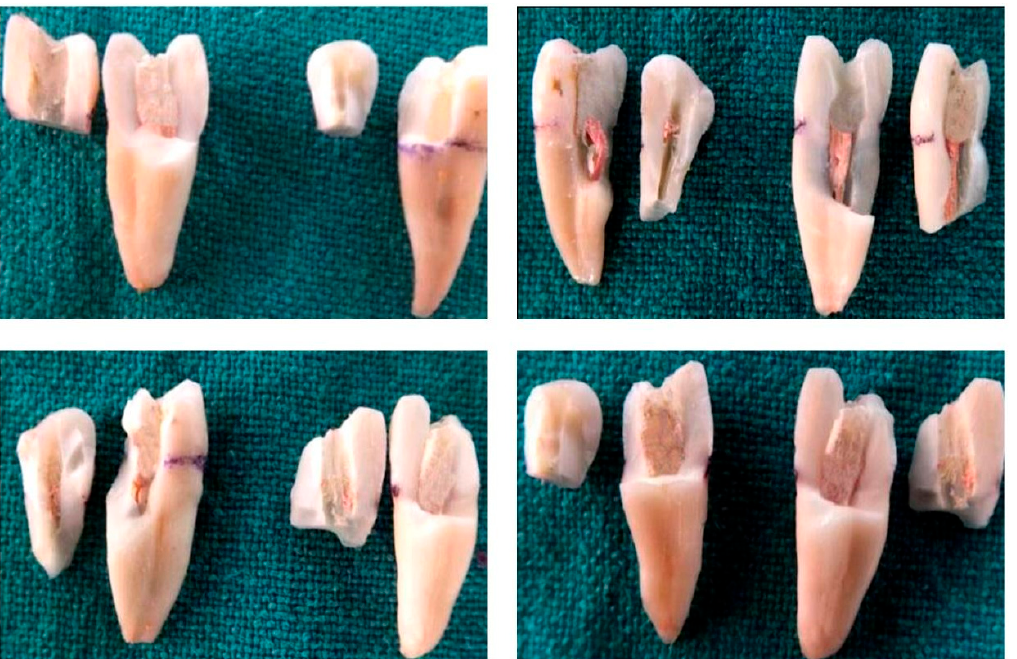
Figure 2. Samples after load testing in Groups I, II, III and IV, respectively.